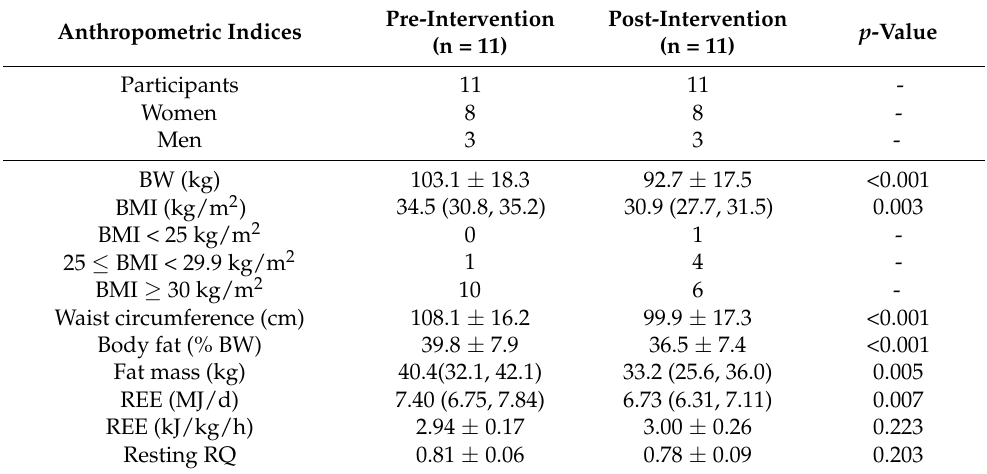
Table 1. Anthropometric, body composition and REE measurements, prior to and